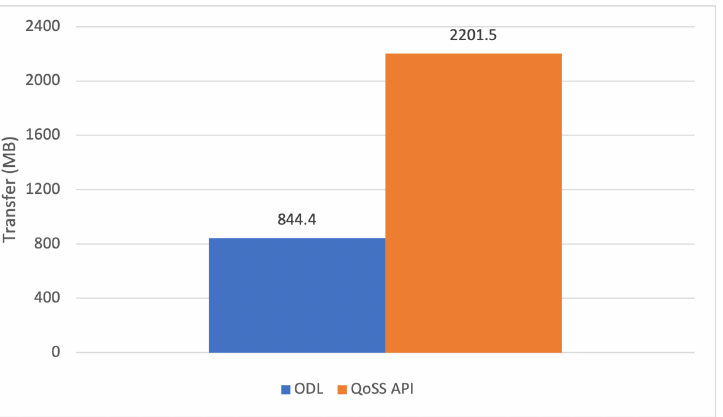
Figure 7. UDP Data transfer comparison. Controller default (ODL -SPF) vs. QoSS API (APP_RT). Time interval: 200 s.